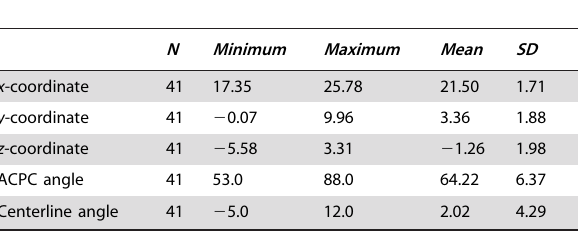
Table 6. Coordinate Analysis of GPi